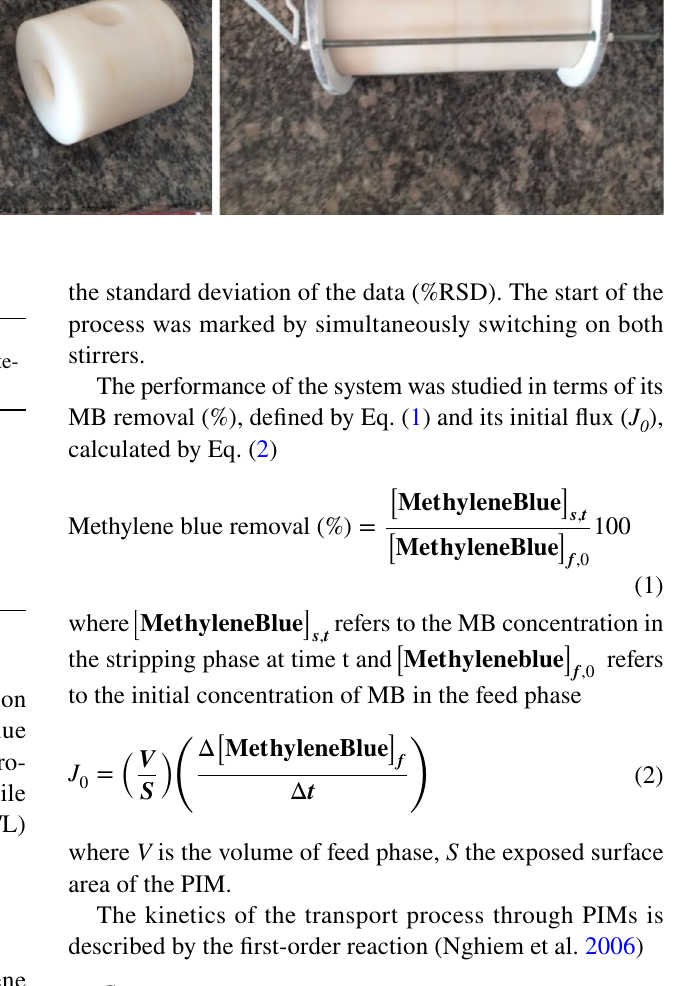
Fig. 2 Membrane reactor used in transport of Methylene Blue (MB)